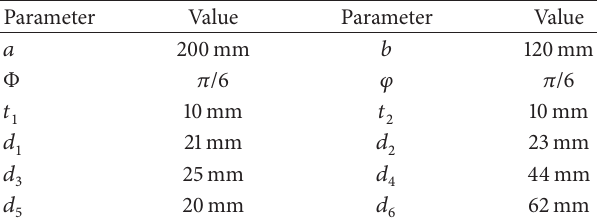
Table 1: Design values of the mechanism